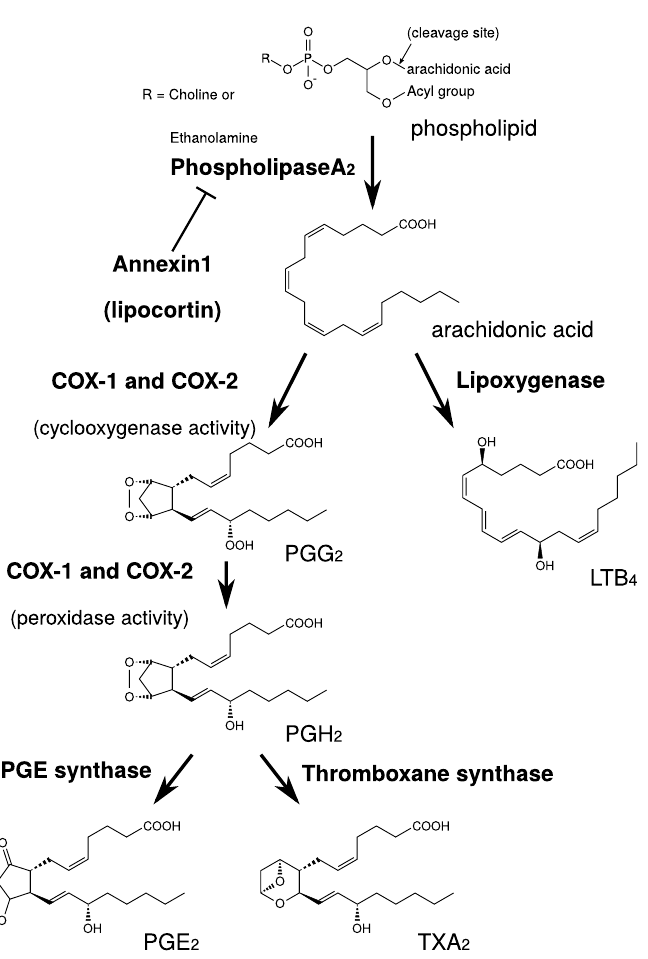
Figure 2. Simplified schema of arachidonic acid